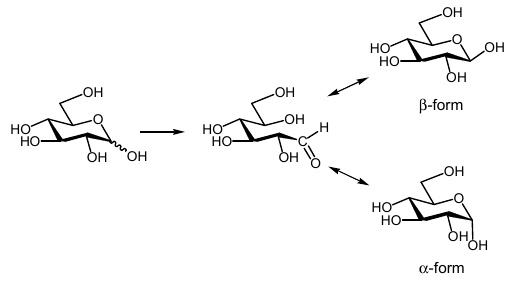
Figure 3. Mutarotation of Glc to interconvert between α -anomer and β -anomer in water.